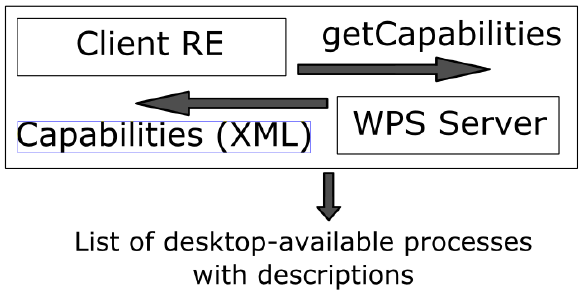
Figure 3. First step of data exchange – requesting capabilities